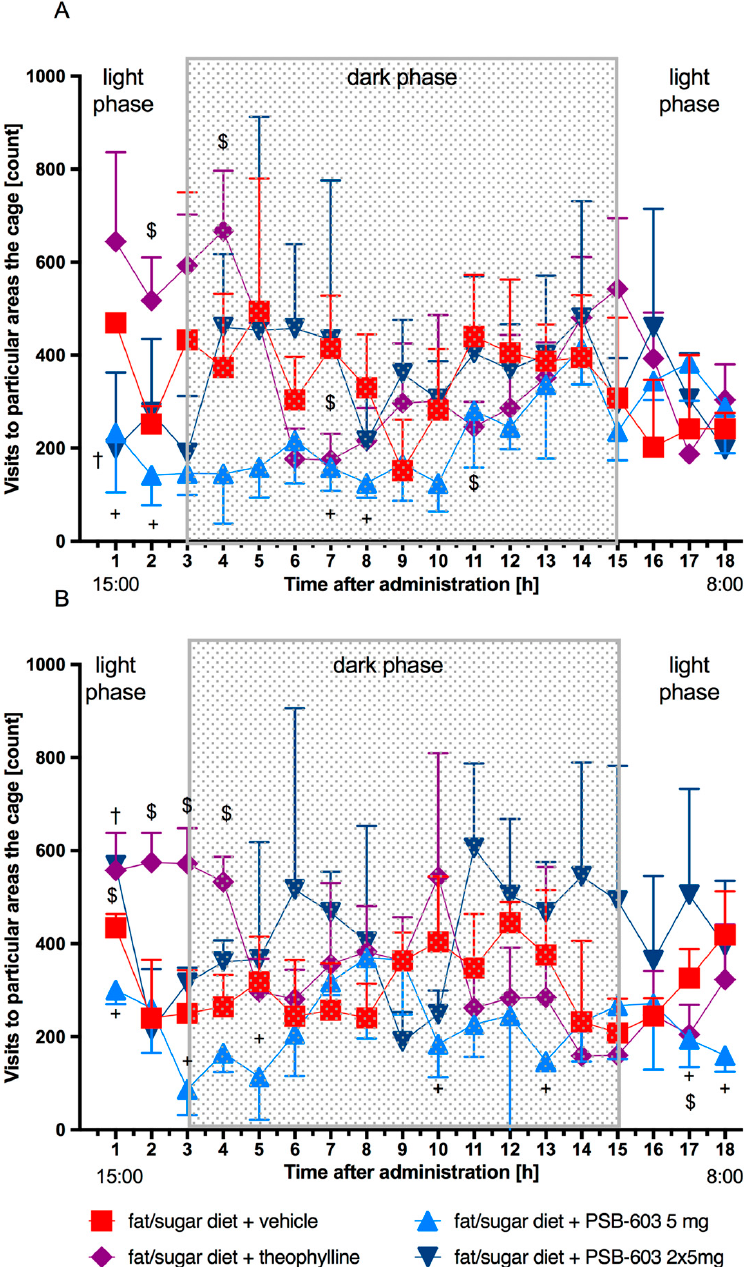
Figure 5. Spontaneous activity measured on the 1st and 13th days of treatment. Results are expressed as means ± SD, n = 8. Comparisons were made using the multiple t test; ( A ) after the first dose; ( B ) after 13 days of treatment; + significant between control mice fed a fat/sugar diet and mice treated with PSB-603 at a dose of 5 mg/kg b.w./day and fed a fat/sugar diet; † significant between control mice fed a fat/sugar diet and mice treated with PSB-603 at a dose of 2 × 5 mg/kg b.w./day and fed a fat/sugar diet; $ significant between control mice fed a fat/sugar diet and mice treated with theophylline at a dose of 2 × 50 mg/kg b.w./day and fed a fat/sugar diet; +, †, $ p < 0.05. After administration of PSB-603 at a dose of 2 × 5 mg/kg b.w. (9.00 am and 1.00 pm) only in the first hour after the second administration mice showed reduced mobility com- pared to the control group. On the thirteenth day of the experiment, the activity of mice treated with PSB-603 (2 × 5 mg/kg) was very close to the activity of mice from the control group, which received only solvent (1% Tween 80). Only in the first hour after the second administration was the activity higher (Figure 5A,B). Theophylline (2 × 50 mg/kg) significantly increased the activity of mice in the light phase on the first day and after subchronic (13 days) administration. The results are shown in Figure 5A,B.